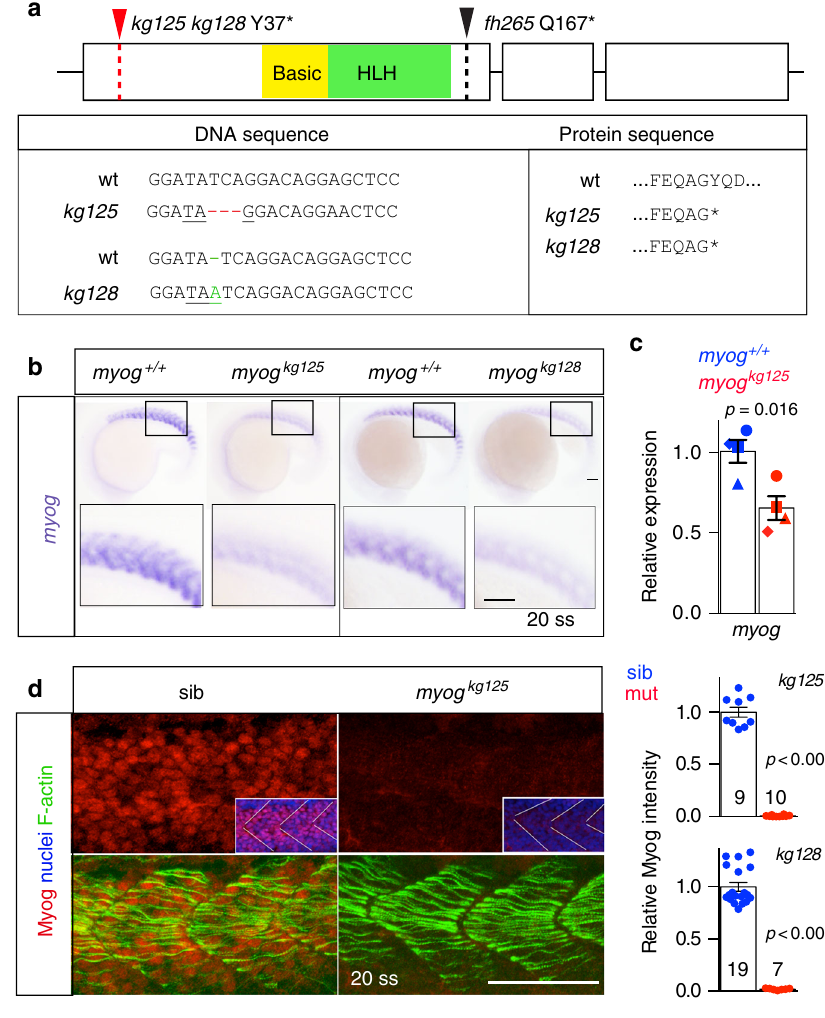
Fig. 1 Genome editing generates zebra fi sh myog null alleles. a Schematic of myog gene exons (boxes) and protein showing the position of kg125 , kg128 and fh265 mutant alleles. The tyrosine to stop mutations (Y37*) produce a truncated protein of 36 amino acids (aa) devoid of both basic (yellow) and helix – loop – helix (HLH, green) domains. The fh265 hypomorphic allele (Q167*) truncates downstream of bHLH. Beneath, DNA and protein alignment of wild-type (wt), 3 bp kg125 deletion (red) and 1 bp kg128 insertion (green) alleles with novel stop codons underlined causing an identical truncation. b In situ mRNA hybridisation (ISH) for myogenin on myog kg128/ + and myog kg125/ + incross lays reveal NMD of mutant myog mRNA at 20 somite stage (20 ss). Representative images n = 14 + 5 mutants, n = 39 + 22 sibs, respectively. Insets show magni fi cation of boxed areas. c qPCR analysis on wt sibs and myog kg125 embryos at 22 ss con fi rms NMD. Mean fold change ± SEM from four independent experiments on genotyped embryos from four separate lays analysed on separate days, paired t test statistic. Symbol shapes denote matched wt and mutant samples from each experiment. d Immunoreactivity of Myog is lost in myog kg125 and myog kg128 mutants at 20 ss, whereas F-actin is unaffected. Insets show nuclear staining in myog kg125 and sib using Hoechst counterstain. Relative myotomal Myog immuno fl uorescence was assessed by nuclear intensity measurement. All images are lateral views anterior to left, dorsal to top. Representative images n = 10 + 7 mutants, n = 9 + 19 sibs, respectively. Bars = 50 µ